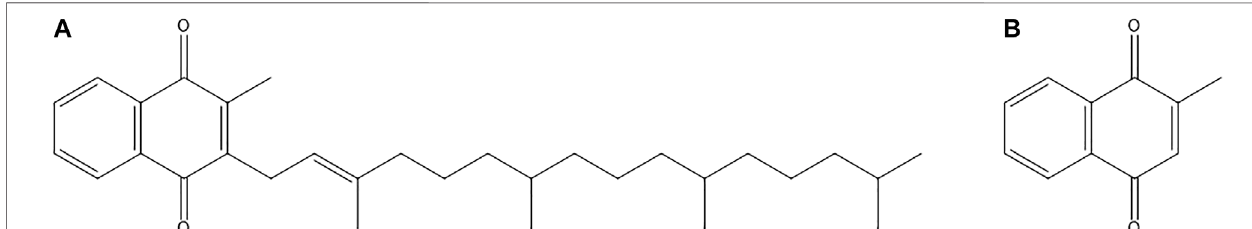
Frontiers in Pharmacology |